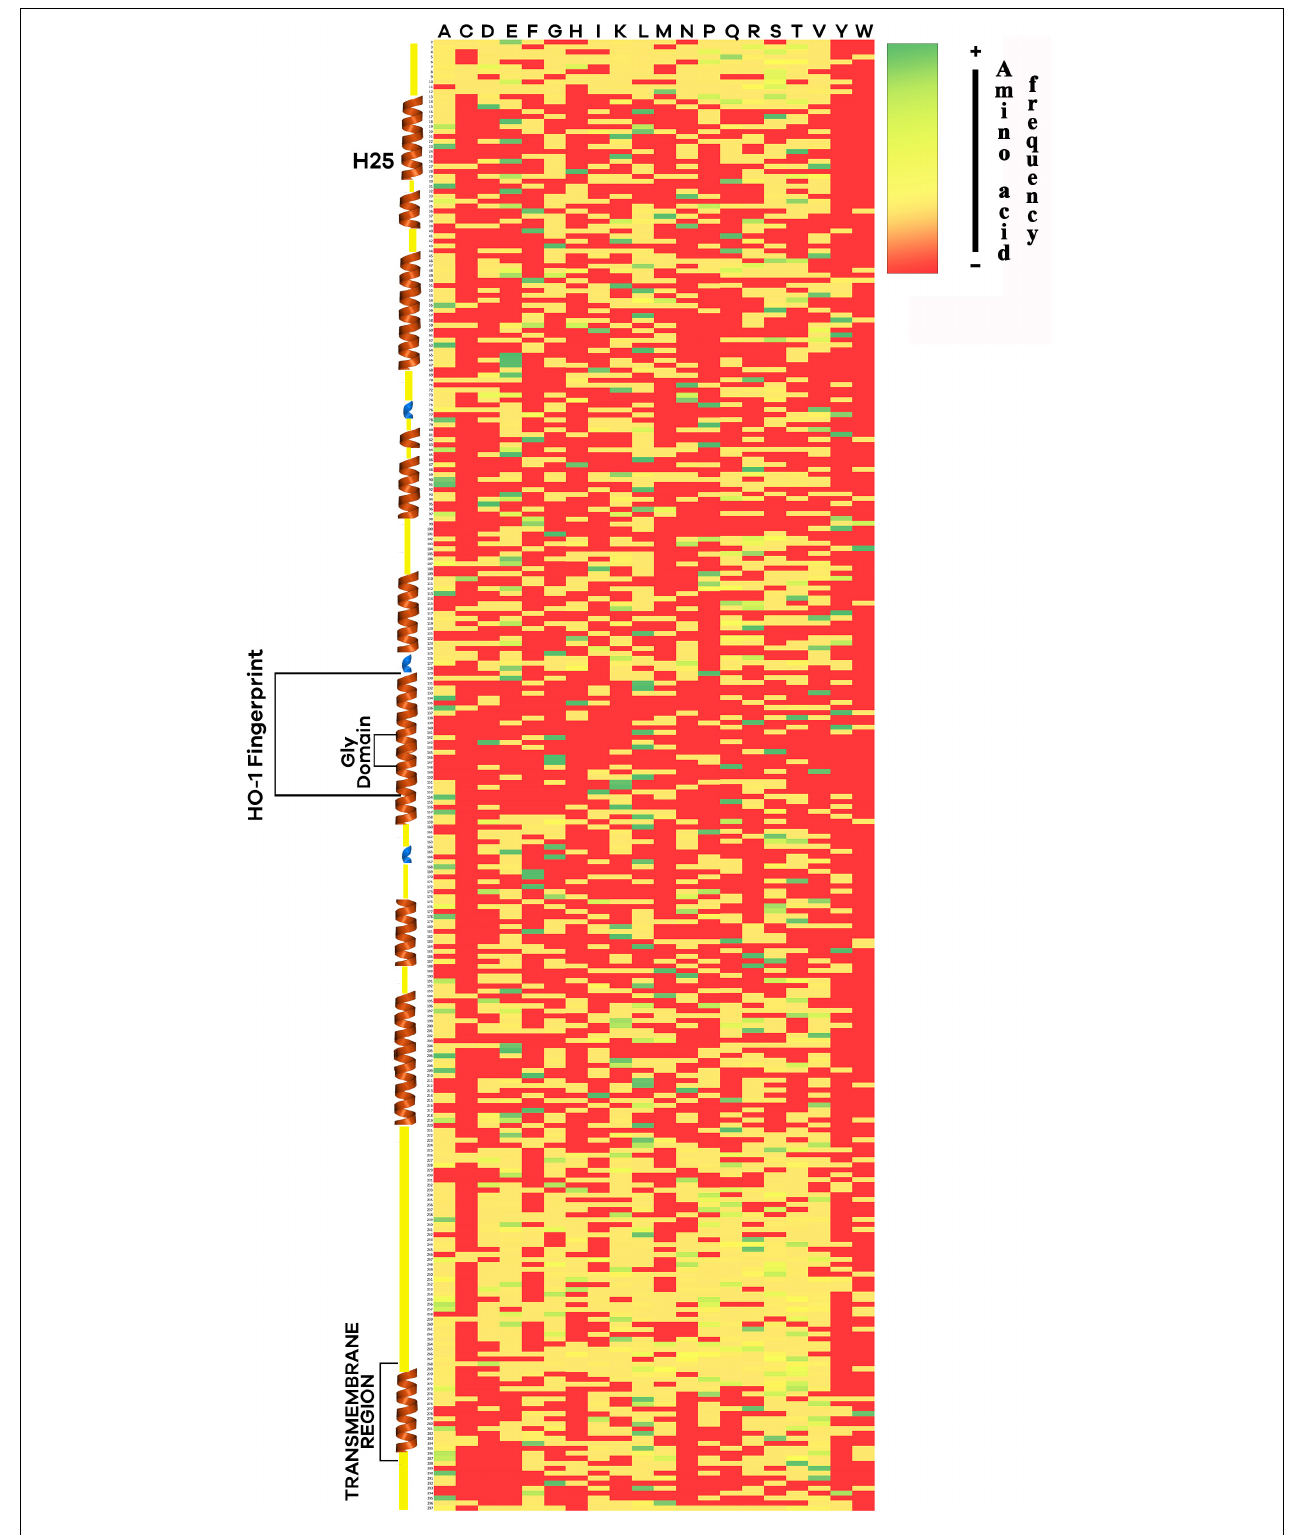
FIGURE 5 | Heat map constructed with the amino-acid sequence of heme oxygenase 1 (HO-1) from 245 eukaryotic species. Tertiary structures predicted from mammal sequences such as alpha-helix (brown) and 3 10 helix (blue) are shown. Histidine-25, HO-1 fingerprint, the glycine domain, and the transmembrane region are indicated. Color indicates the frequency of an amino-acid across all the sequences, green for more frequency, red for none.